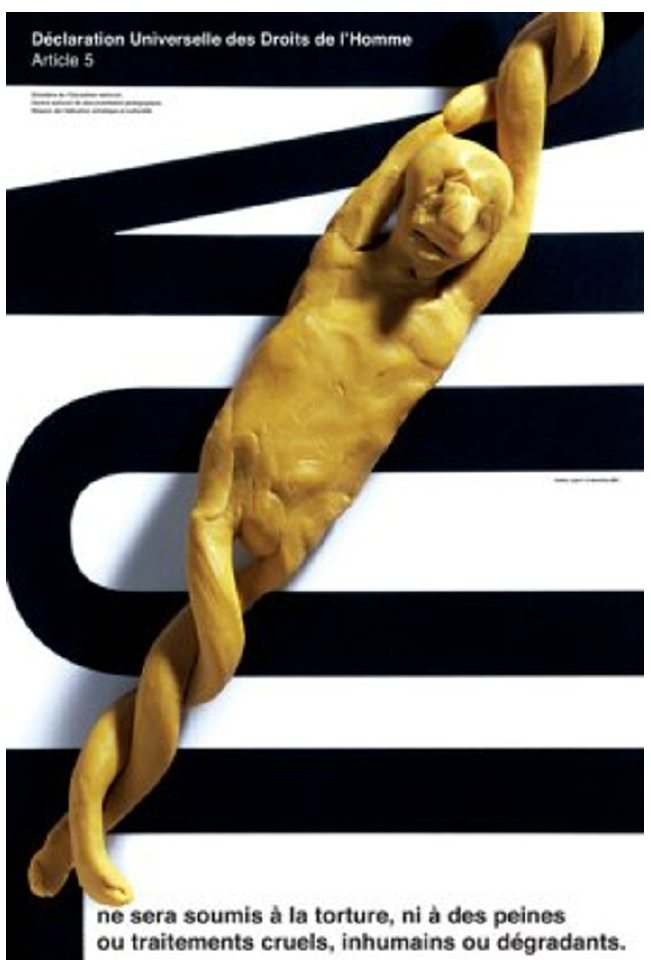
Fig. 3 Andrey Logvin, poster